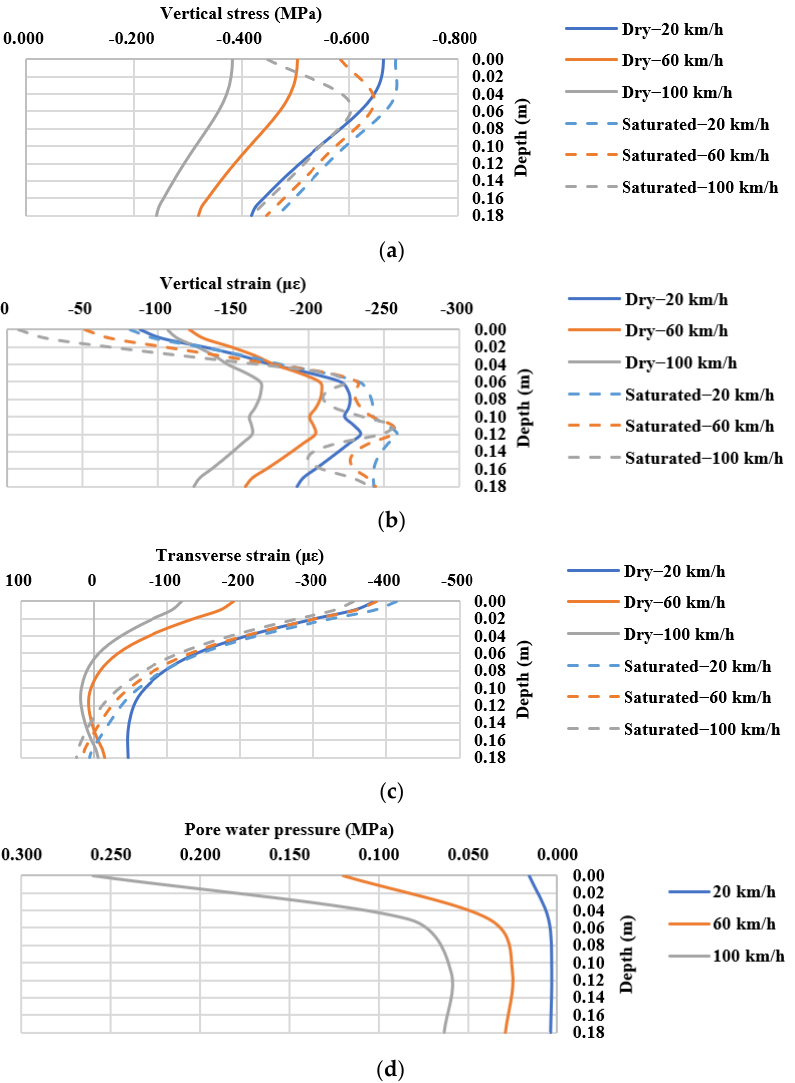
Figure 14. Vertical distributions of dynamic responses along depth in asphalt pavement: ( a ) Vertical stress; ( b ) Vertical strain; ( c ) Transverse strain; ( d ) Pore water pressure.